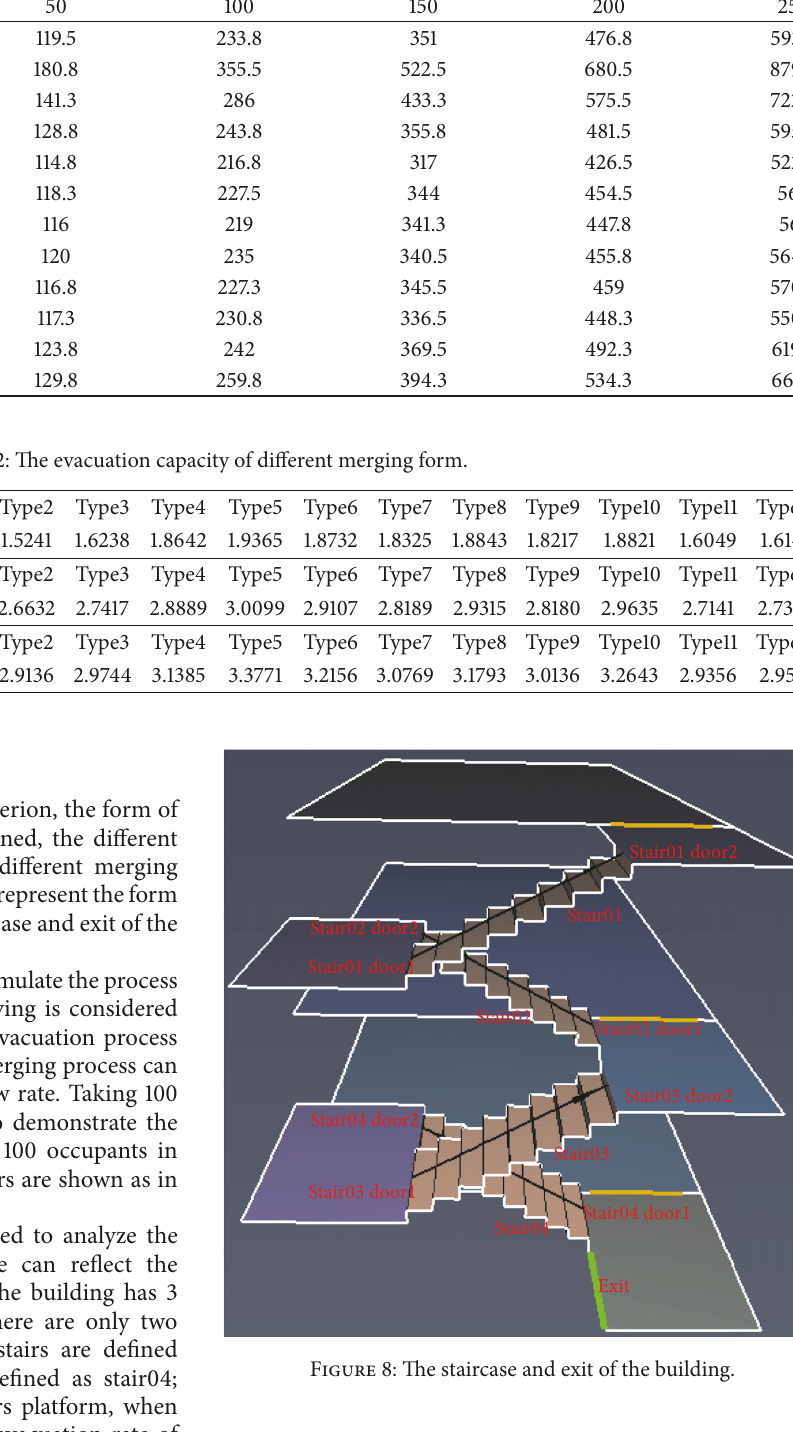
of evacuation. Therefore, the number of occupants in the process of merging is less and the time of merging is short; meanwhile, the fluctuation of evacuation rate in stair03 and stair04 is less and only smaller change appears during the evacuation peak. Taking type1 merging as an example,